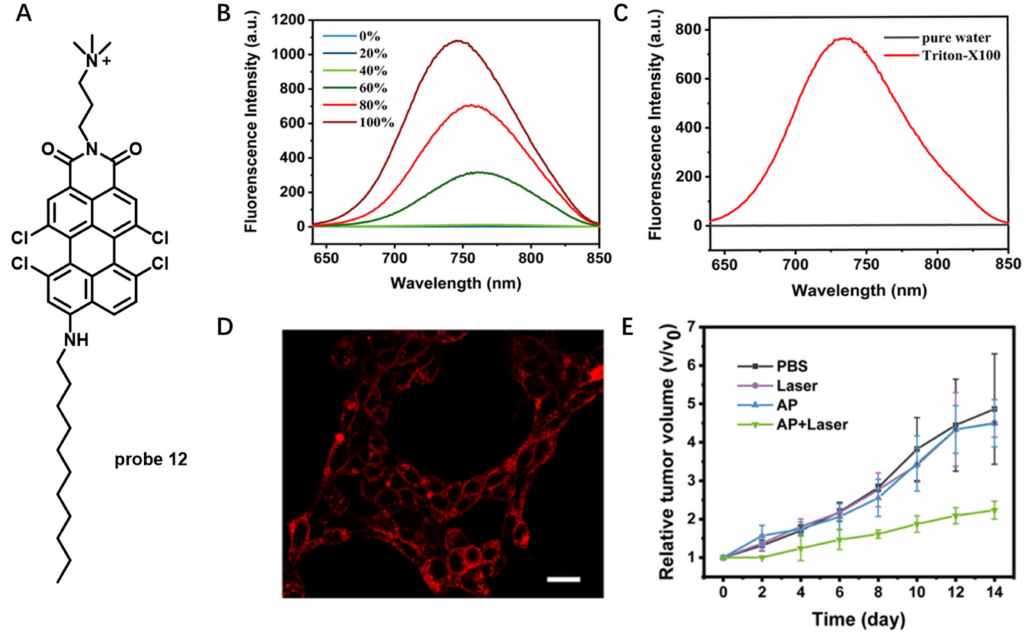
Figure 12. ( A ) Chemical structure of probe 12 . ( B ) Emission spectra of probe 12 in water mixed with increasing percentage of CH 3 OH. ( C ) Emission spectra of probe 12 in the absence or presence of Triton-X100. ( D ) Fluorescence images of CM stained with probe 12 . Scale bar: 100 µ m. ( E ) Tumor volume changes of the 4T1 tumor-bearing mice under different treatments. Copyright 2021 American Chemical Society